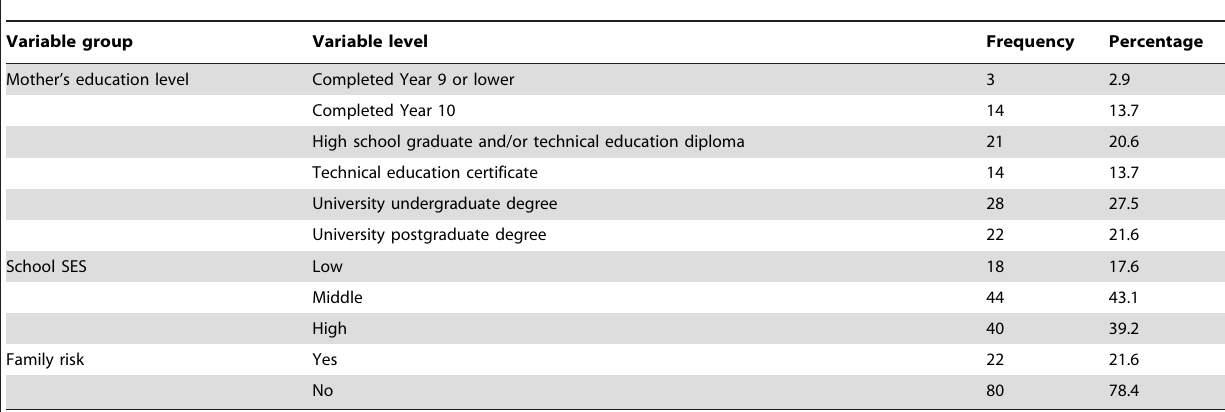
Table 1. Demographic characteristics of children in the